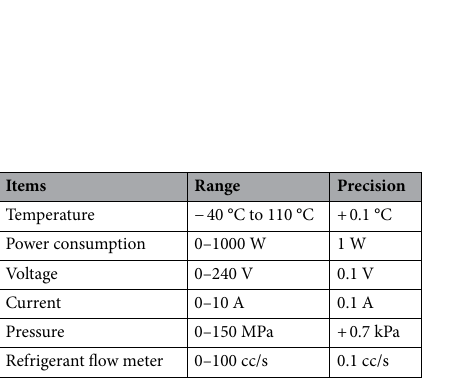
Table 2. Items measured, together with their range and